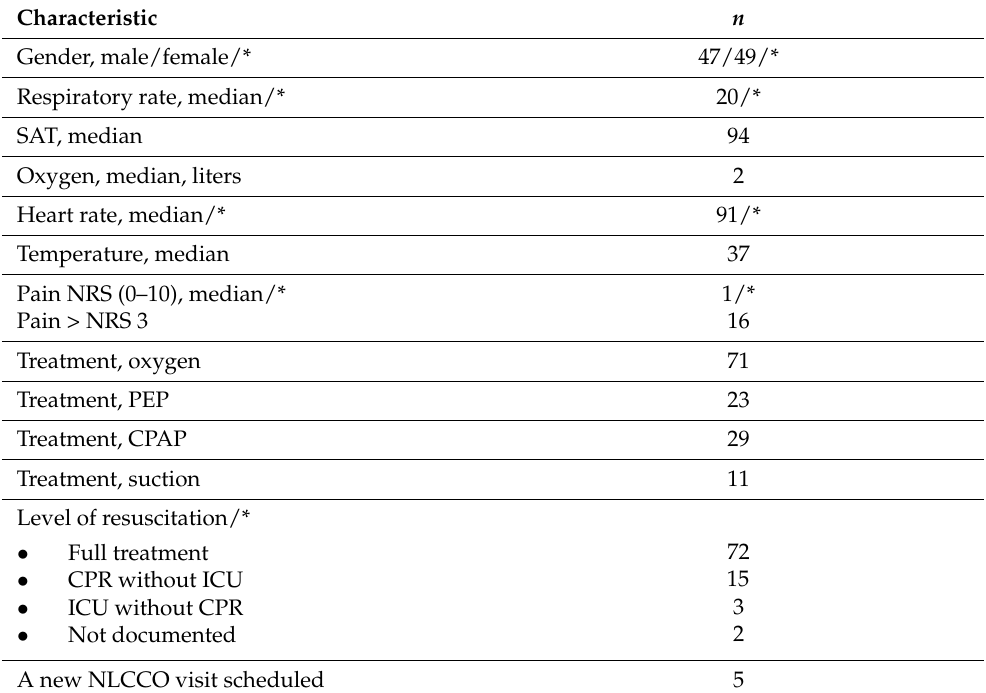
Table 1. Characteristics and treatment of patients identified as at-risk (N =